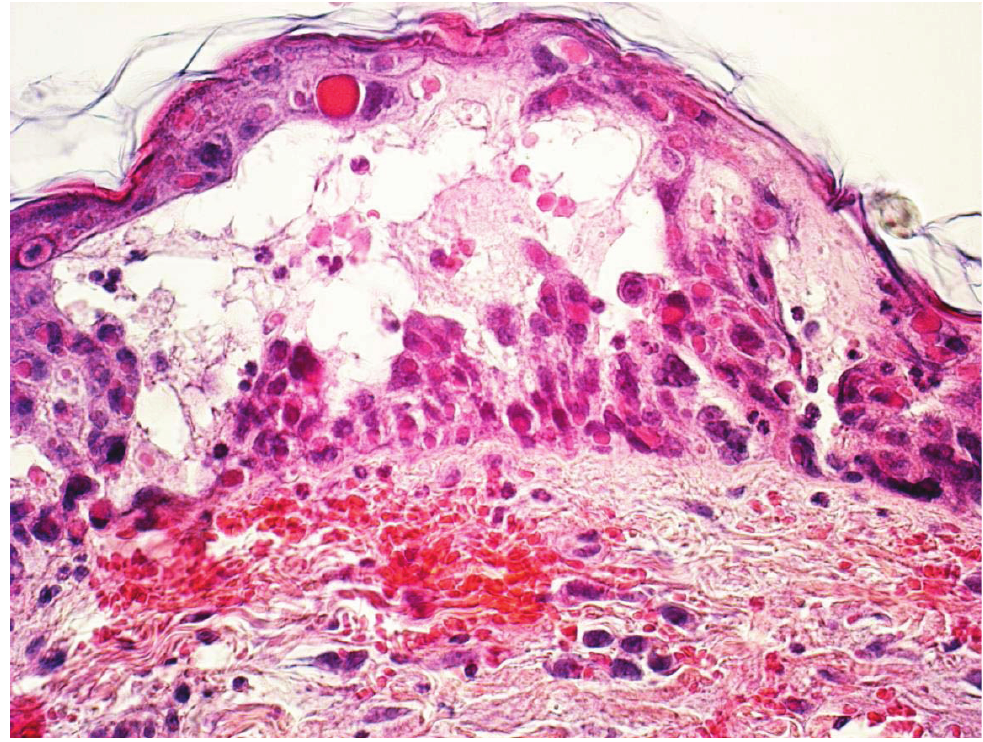
Figure 4. Calpox virus infected saddle back tamarin, skin. High-grade, focal, vesicular dermatitis with intracytoplasmatic eosinophilic inclusion bodies, ballooning degeneration and